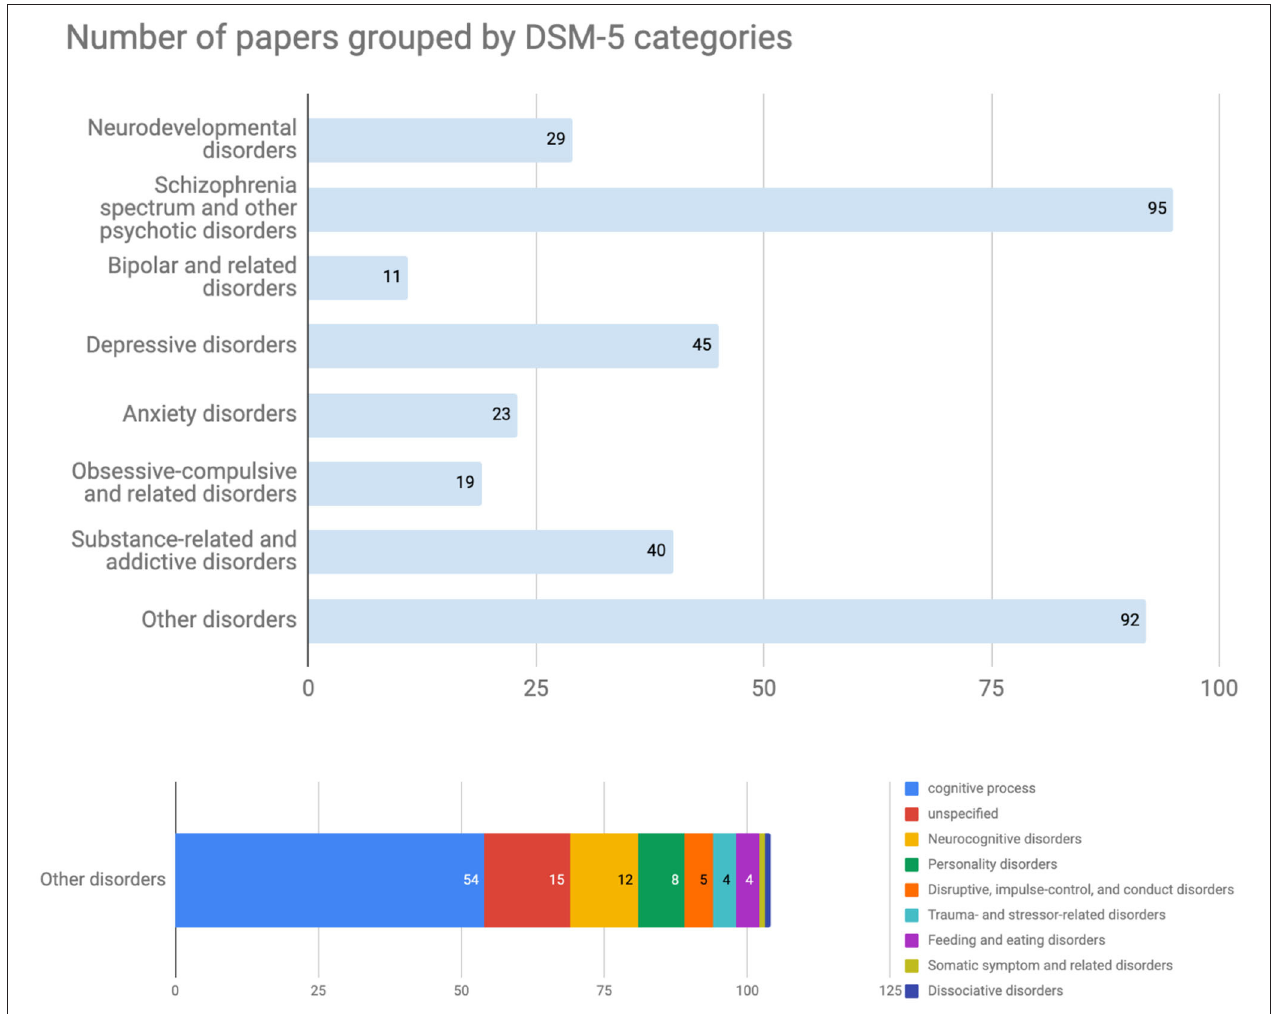
FIGURE 3 | Number of papers grouped by DSM-5 categories. The most popular diseases in this database were schizophrenia spectrum and other psychotic disorders. The bar labeled “Others disorders” included papers targeting 13 other disorders and normal cognitive functions that were tagged as cognitive processes at the registration